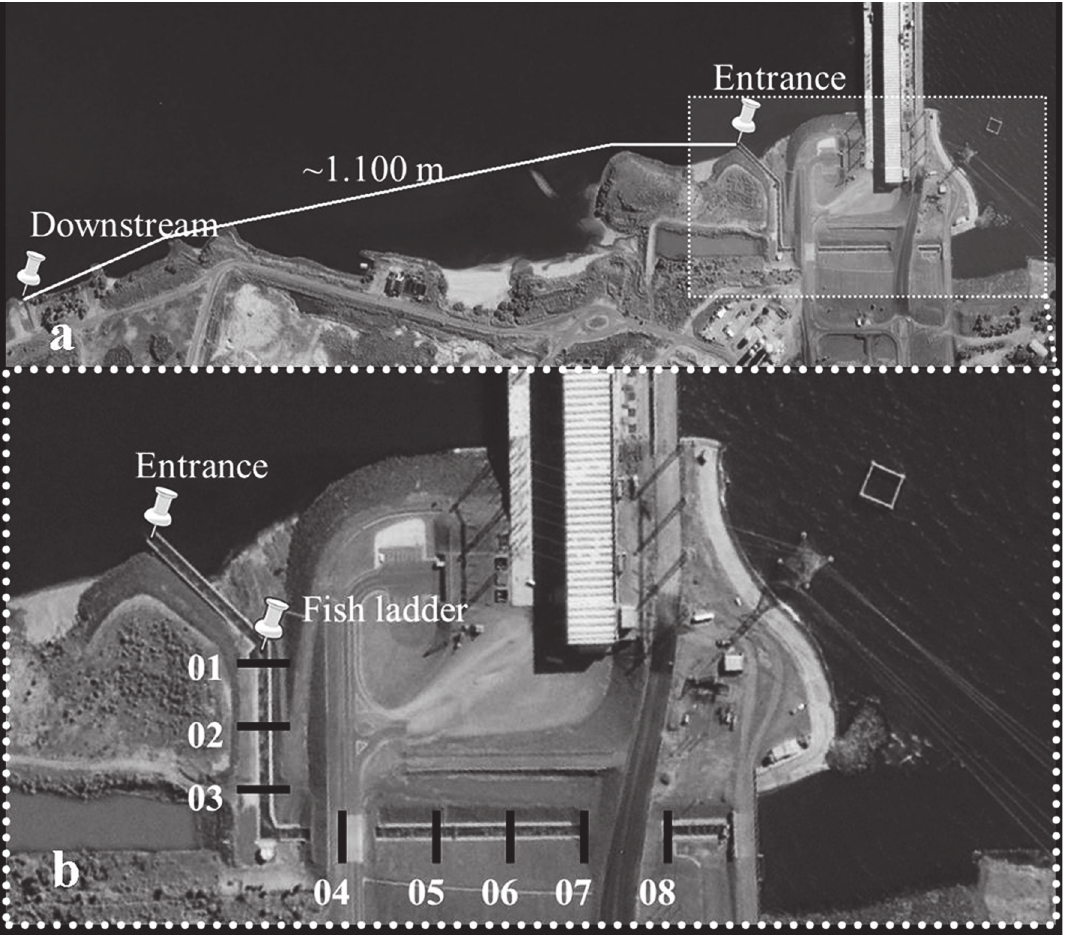
Fig. 2. Fish release sites: a ) downstream, and b ) fish ladder - distribution of antennas (01 to 08) along the fish ladder at the Engenheiro Sérgio Motta (Porto Primavera) Hydroeletric Power